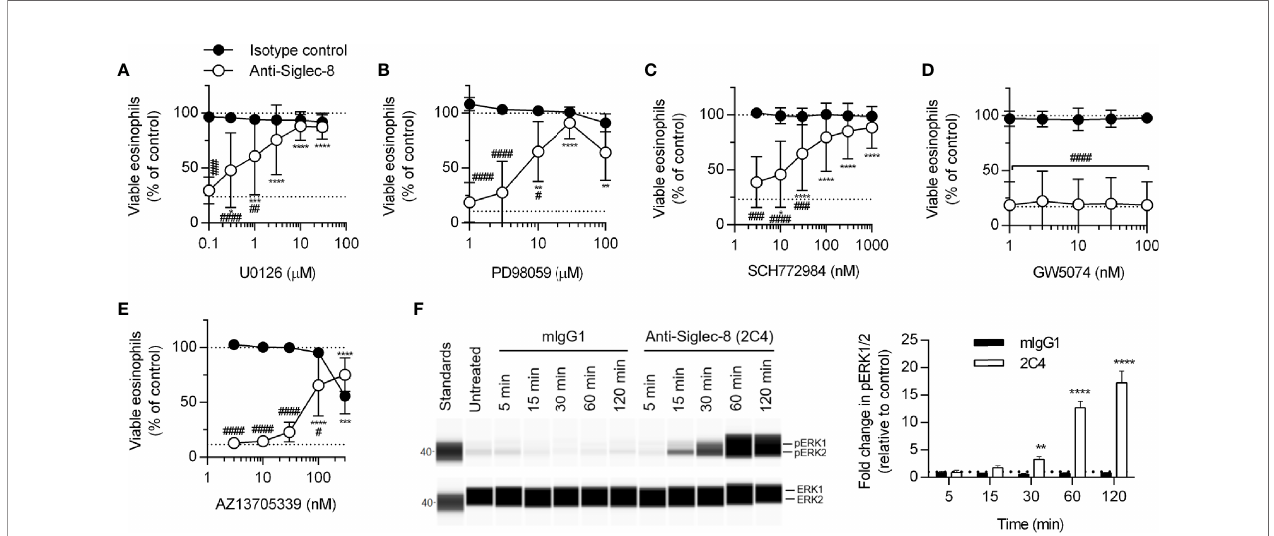
FIGURE 4 | The activities of MEK1, ERK1/2, and PAK1 are necessary for Siglec-8 – induced eosinophil cell death. Peripheral blood eosinophils were stimulated with 30 ng/ml IL-5 overnight and pretreated with the indicated concentration of the MEK1/2 inhibitors U0126 (A) or PD98059 (B) , ERK1/2 inhibitor SCH772984 (C) , c- Raf inhibitor GW5074 (D) , or PAK1/2 inhibitor AZ13705339 (E) for 30 min prior to 18 – 24-h treatment with anti-Siglec-8 (open circles) or isotype control mAb ( fi lled circles). Cell viability was then assessed by annexin V/DAPI staining by fl ow cytometry. Dotted lines indicate viability levels with no pharmacological inhibition for inhibitors plotted on a logarithmic scale. Plots represent the mean percentage of viable eosinophils normalized to the viability of untreated eosinophils ± standard deviations for 3 independent experiments. *p < 0.05, **p < 0.01, ***p < 0.001, ****p < 0.0001 relative to within – antibody stimulation group vehicle control sample. # p < 0.05, ## p < 0.01, ### p < 0.001, #### p < 0.0001 relative to isotype control sample at the same pharmacological inhibitor concentration. (F) IL-5 – primed eosinophils were treated with anti-Siglec-8 mAb or isotype control mAb (mIgG1) for the indicated durations prior to lysis and detection of phospho- (pT202/pY204) or total ERK1/2 using an automated protein separation and immunodetection platform. Blot is representative and quanti fi ed data represent the means and standard deviations of three independent experiments. **p < 0.01; ****p < 0.0001 vs. isotype control at the same time